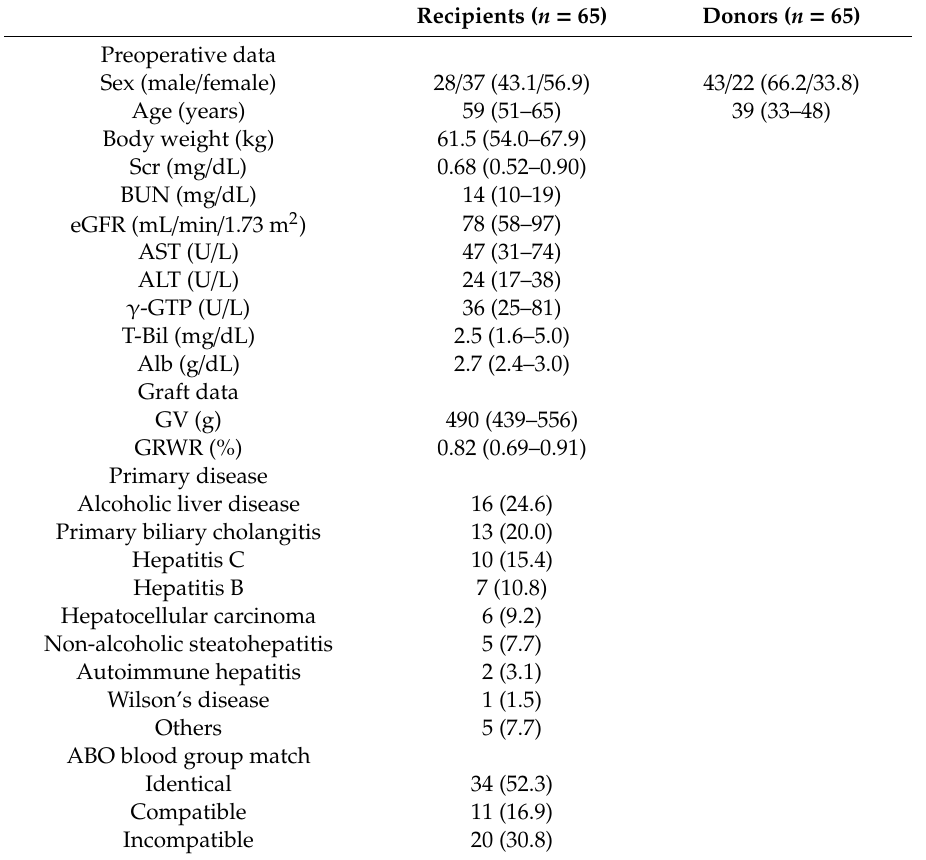
Table 1. Characteristics of recipients and